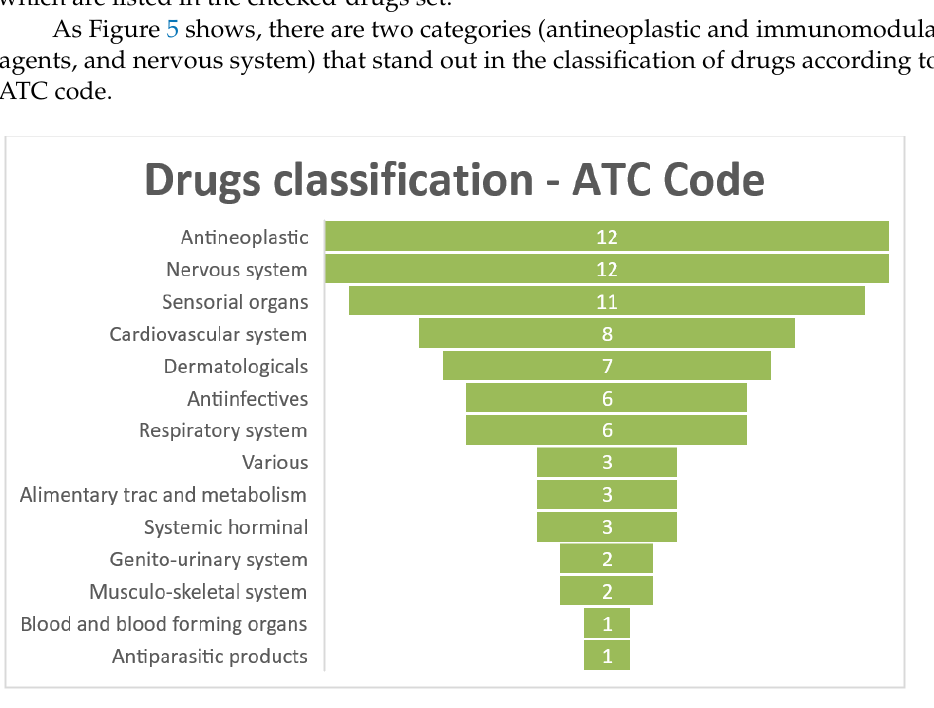
Figure 5. Classification of the potential drugs according to the first level of the ATC